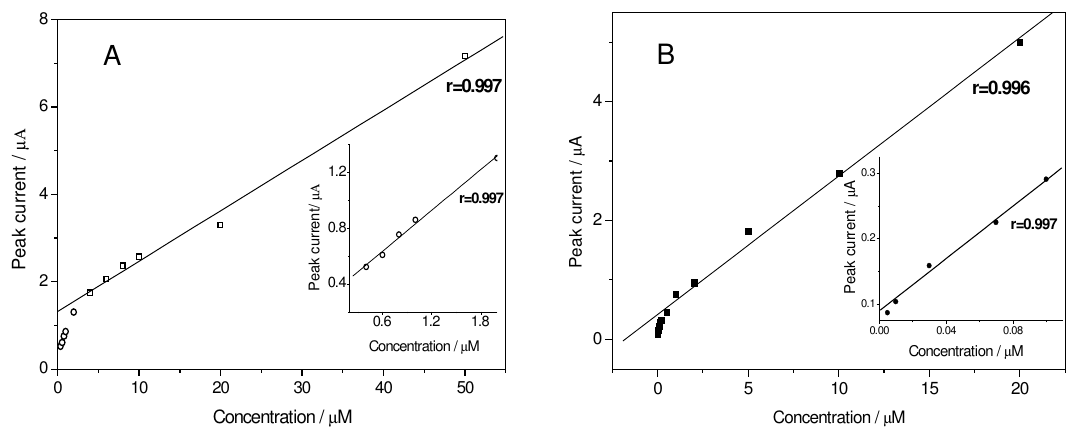
Figure 7. Dependence of peak current on porchlorperazine (A) or ethopropazine (B) concentration. (A) t : 60 s, E : –0.4 V; (B) t : 60 s, E : 0 V. Other conditions as in Figure 1. Insert: the linear calibration d d d d plot of prochlorperazine/ ethopropazine at lower concentration